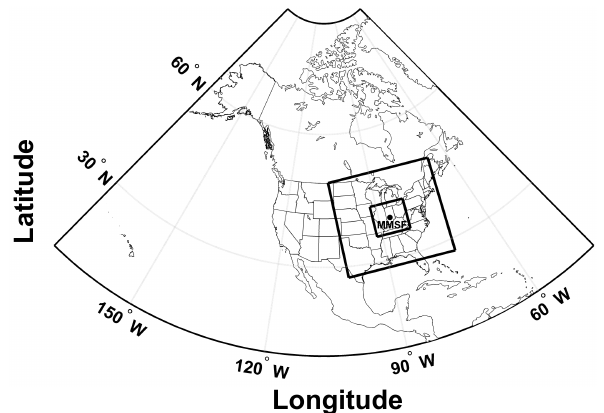
Fig. 3. Parent and nested domain simulated by WRF imposing a spatial resolution of 9km and 3km respectively. The location of the MMSF site is also shown.